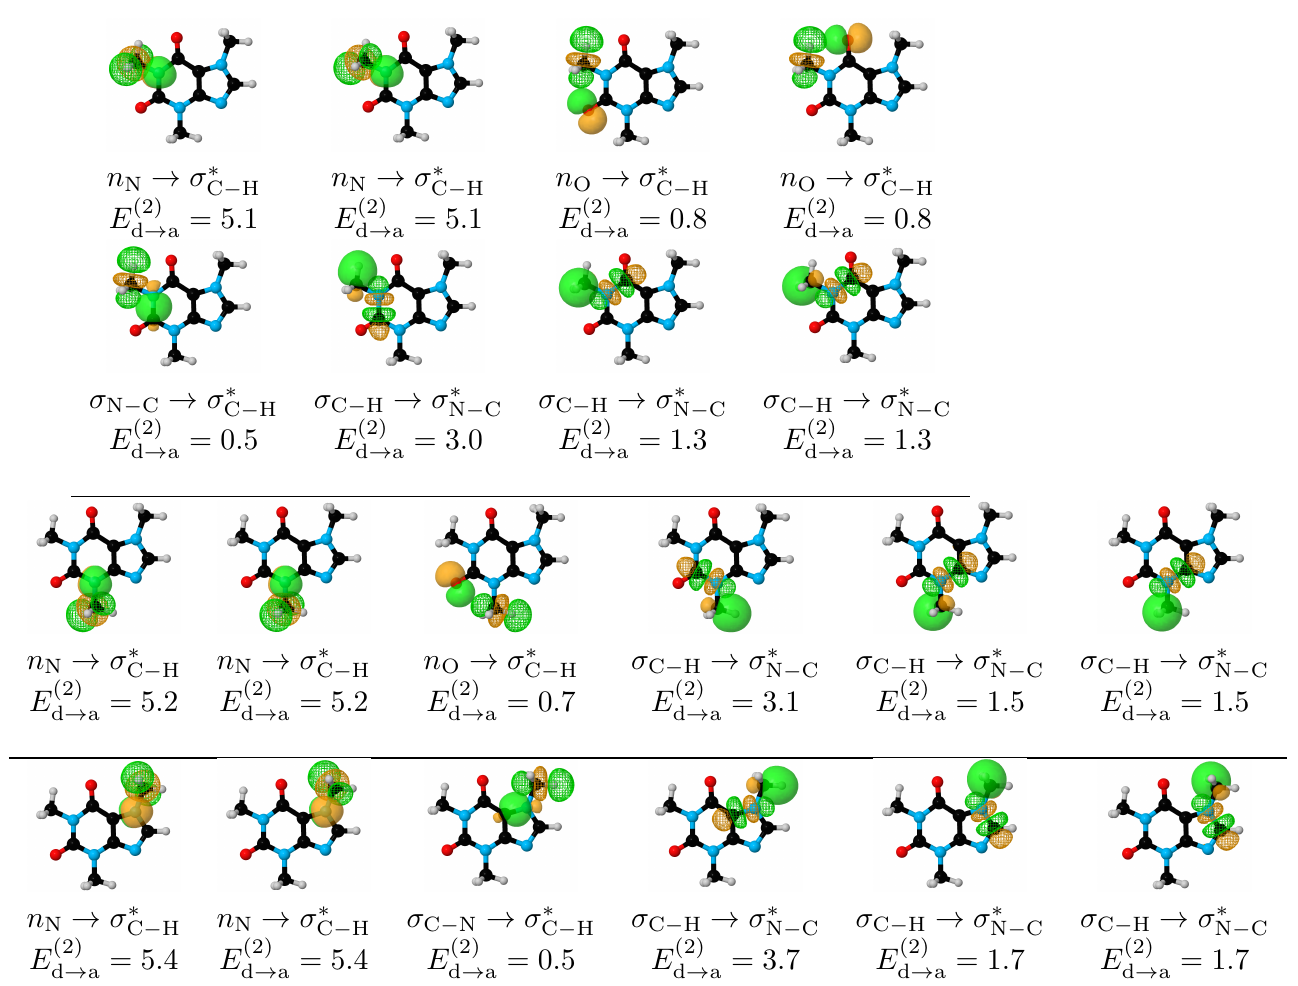
Figure 5. Donor (solid surfaces) → acceptor (meshed surfaces) orbital interactions for the conformer I of caffeine. All interactions are of the vicinal type (no geminal or remote hyperconjugation). All energies in